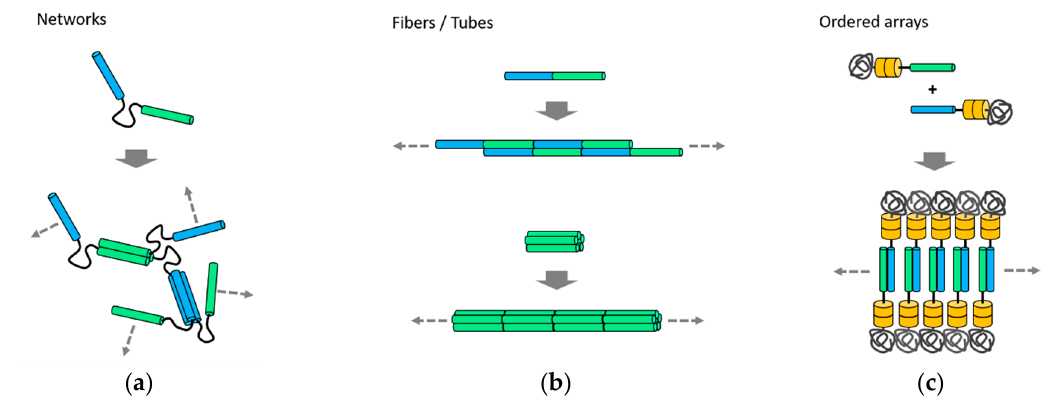
Figure 3. Self-assembly of unbounded nanostructures. ( a ) Formation of networks using coiled-coil fusion proteins with a flexible linker [46,47]; ( b ) assembly and co-directional alignment of coiled-coil building blocks, followed by longitudinal growth into fibers [26,27] or tubes [28]; ( c ) lamellar-ordered arrays assembled from protein-polymer conjugates [39]. Directions of the unbounded growth are indicated by